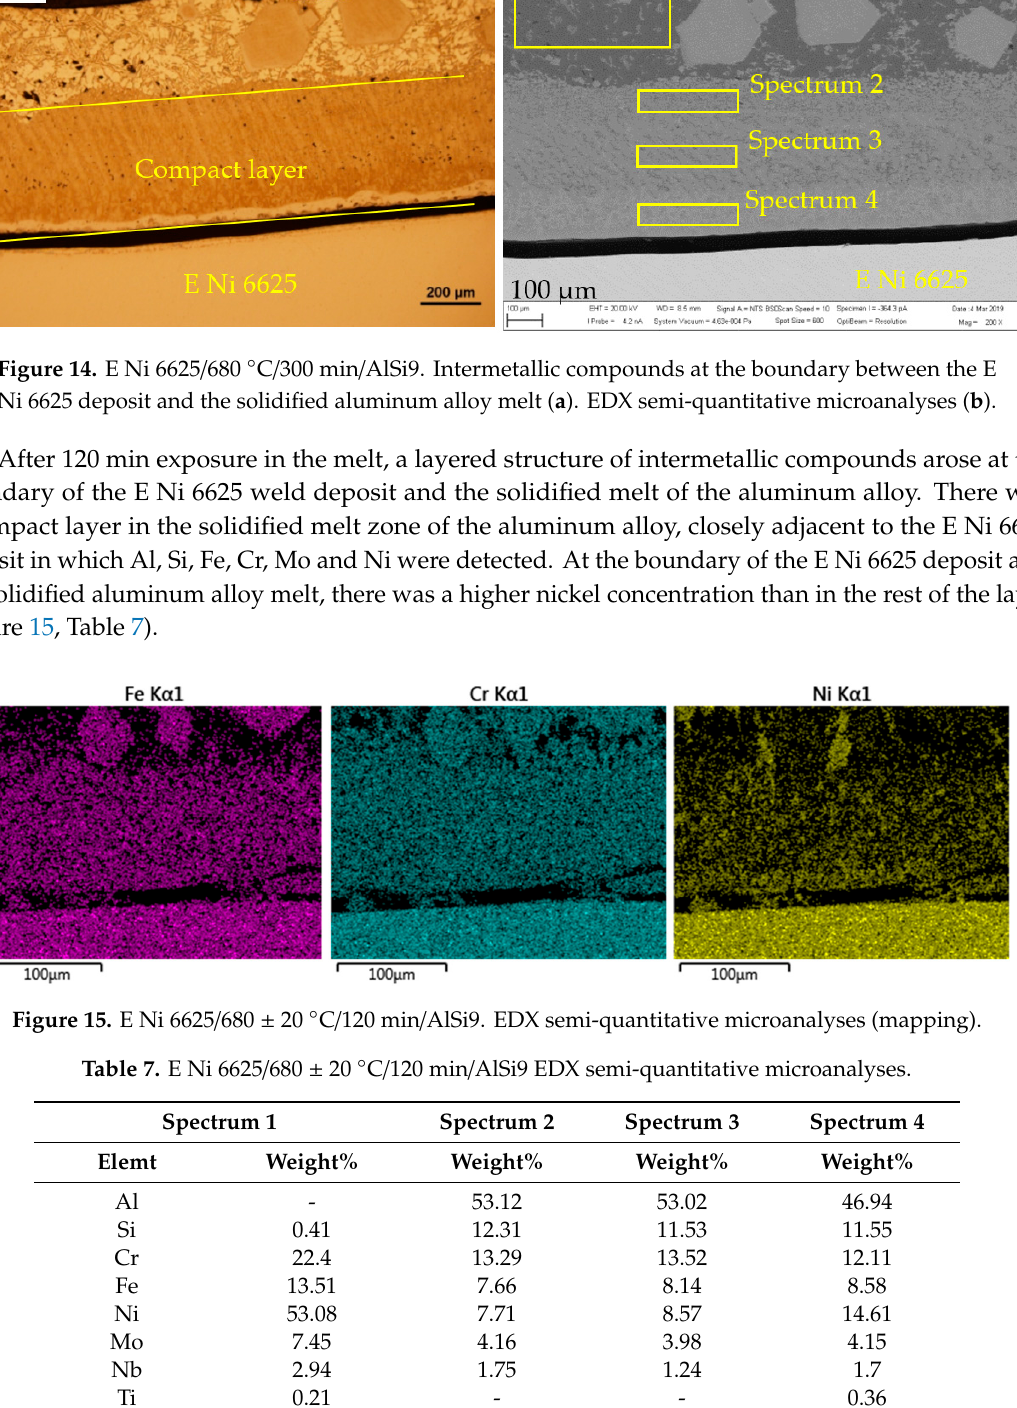
Figure 16. E Ni 6625/680 ± 20 °C/300 min/AlSi9. EDX semi-quantitative microanalyses (mapping).